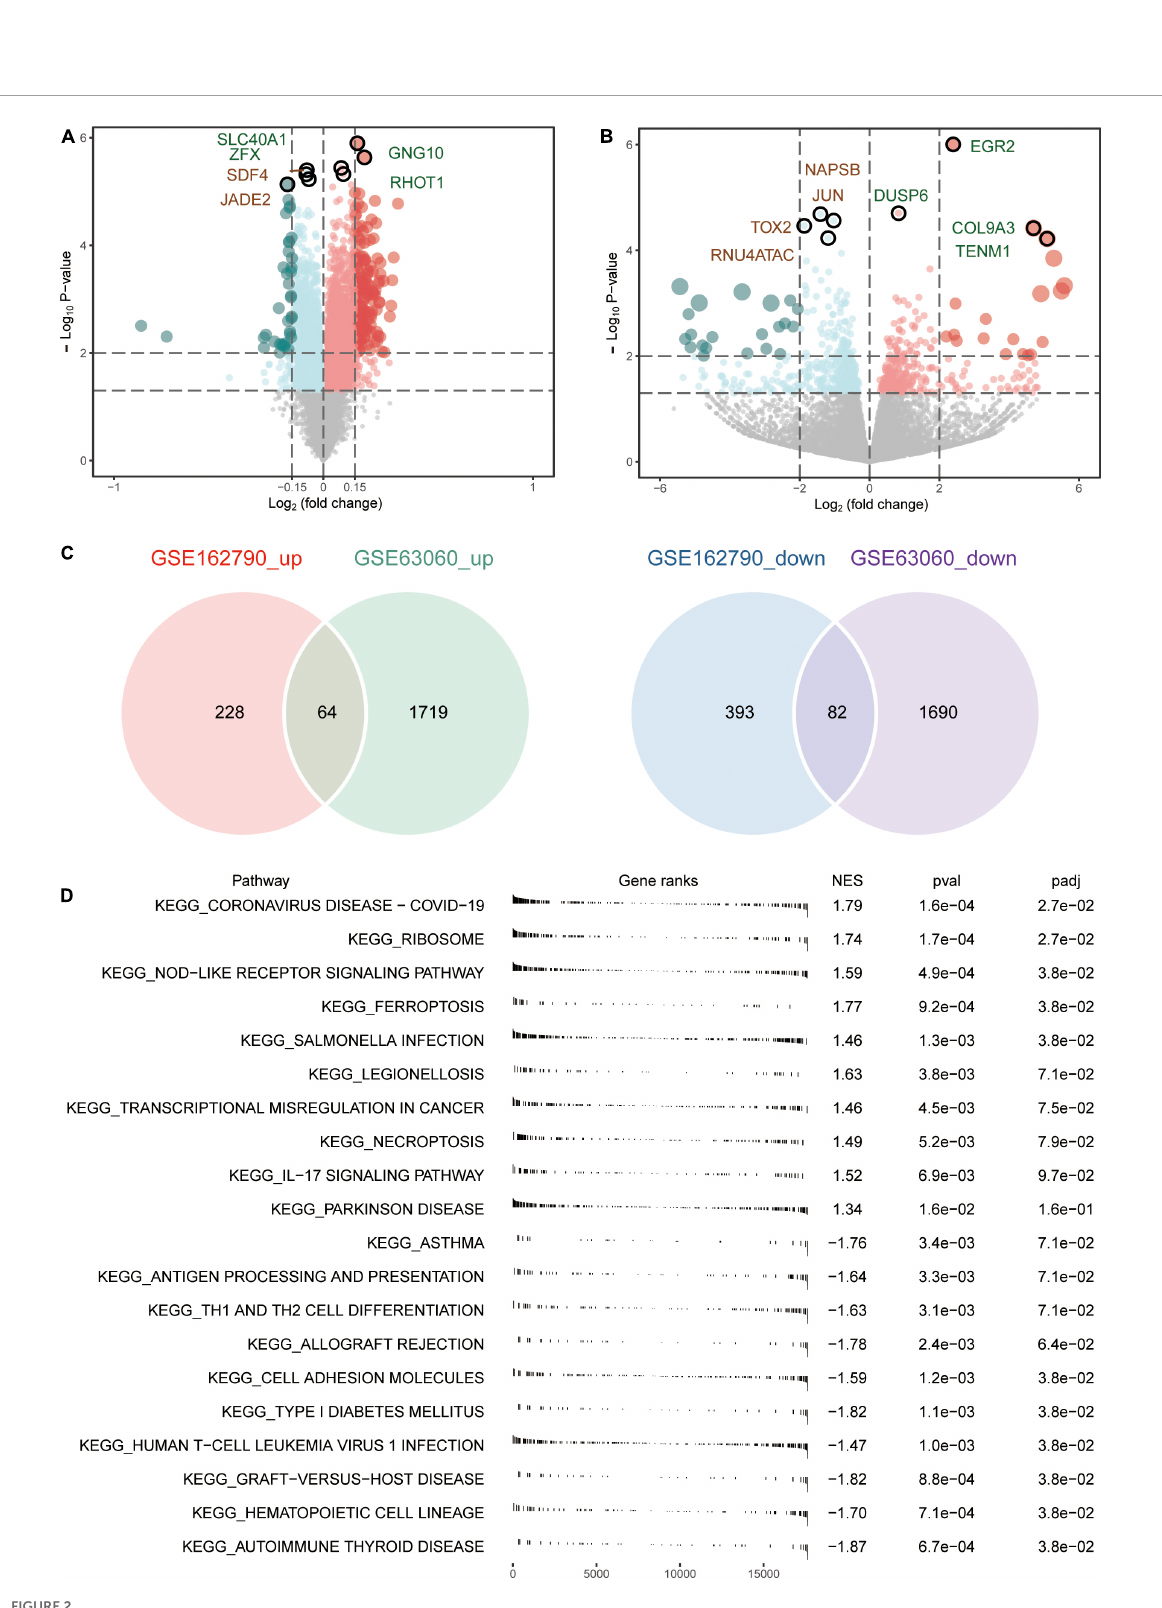
FIGURE2 Aberrantly expressed genes in AD and CSVD progression. (A) Volcano plot of differentially expressed genes between AD and MCI. Red dots are up-regulated, and green dots are down-regulated. (B) Volcano plot of differentially expressed genes between CSVD progression and CSVD no-progression. Red dots are up-regulated, and green dots are down-regulated. (C) The intersection of up-regulated or down-regulated DEGs in GSE63060 and GSE162790 datasets were considered common DEGs. (D) KEGG pathways of GSEA in AD or MCI. NES, normalized enrichment score; p -val, P -value; p- adj, adjust P